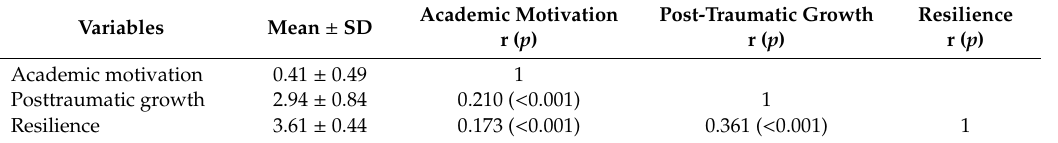
Table 2. Correlations among motivation, post-traumatic growth, and resilience ( n = 291). Variables